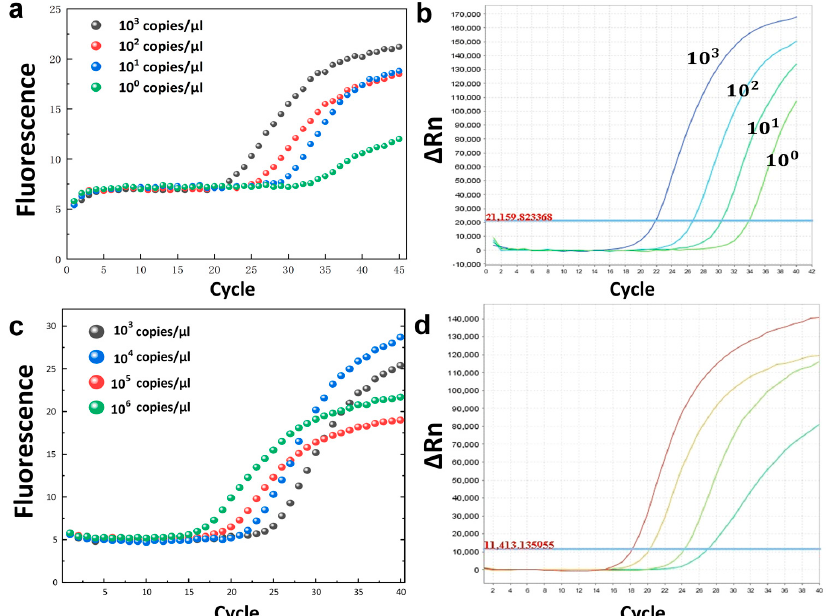
Figure 3. ( a ) HDLRT-qPCR gradient amplification curves for African swine fever. ( b ) African swine fever gradient amplification curves for real-time PCR amplification (ABI-STEPONE). ( c ) SARS-CoV-2 (gene target: ORF1ab) gradient amplification curves for the HDLRT-qPCR system. ( d ) ABI-STEPONE real-time PCR amplification system SARS-CoV-2 (gene target: ORF1ab) gradient amplification curves.